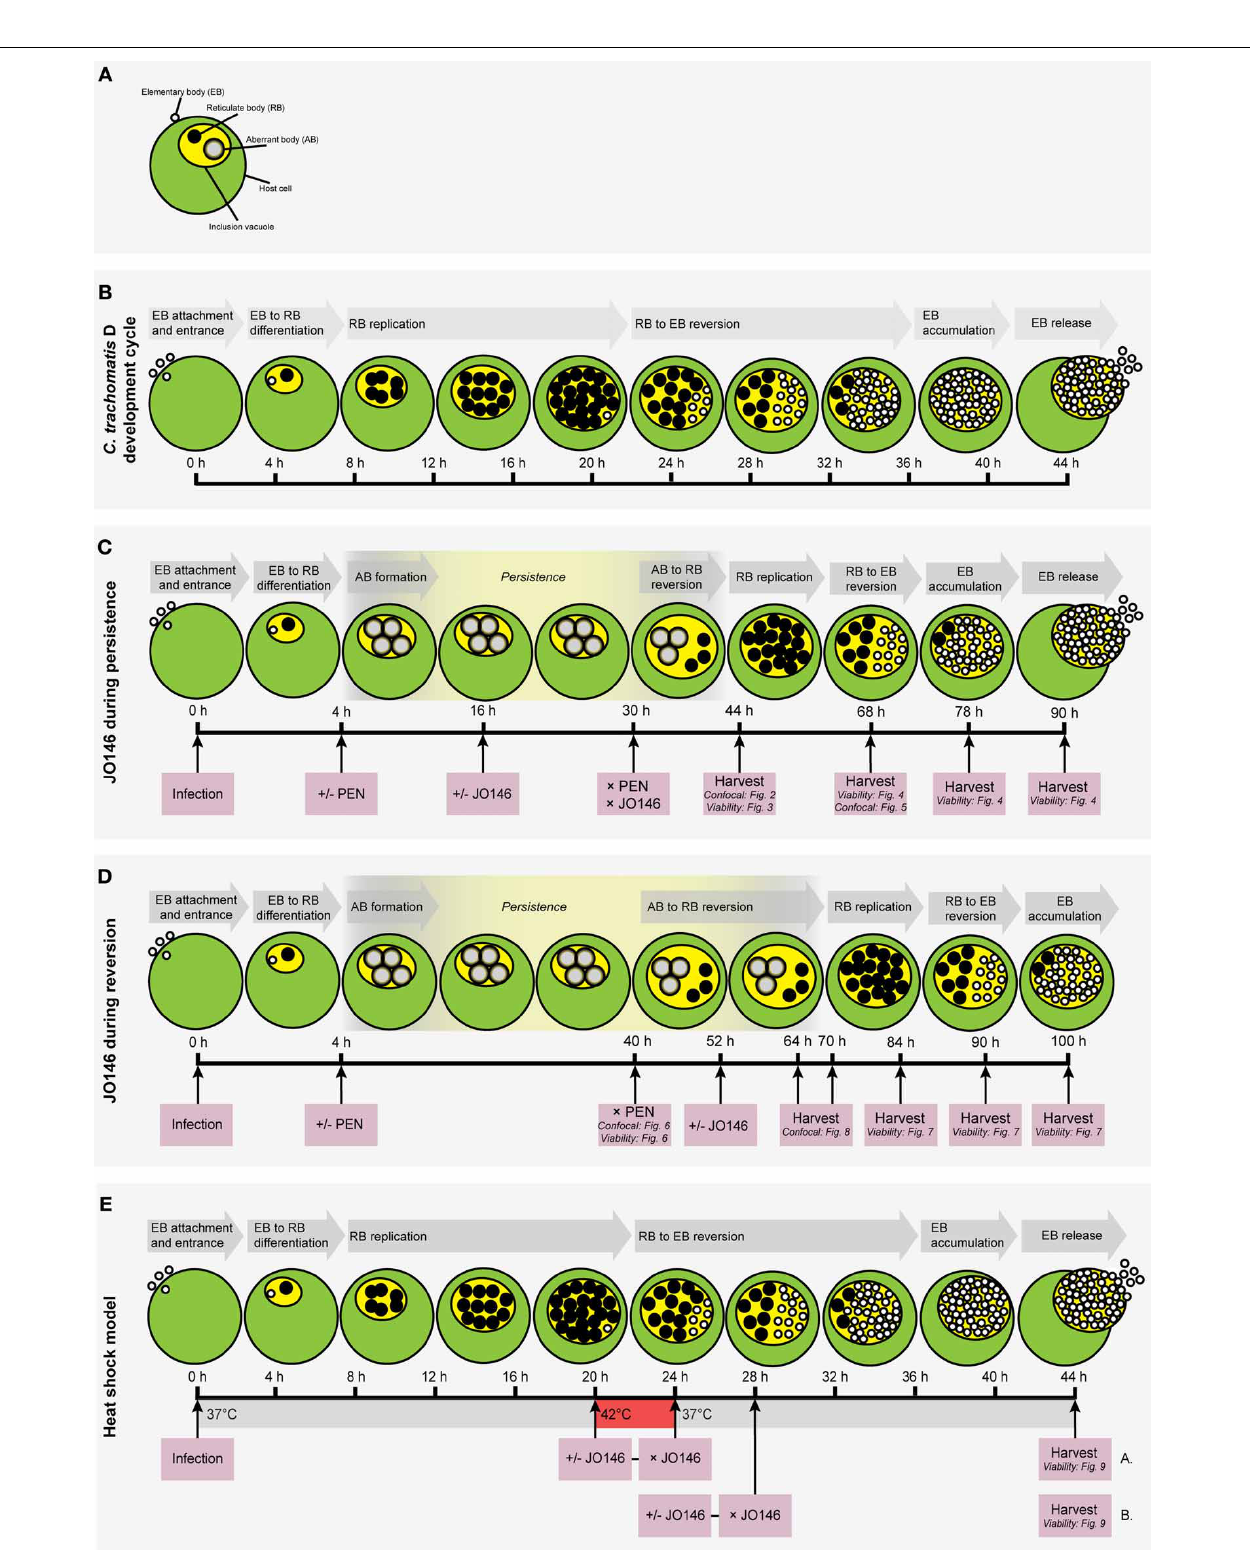
FIGURE 1 | Flow chart diagrams of methodologies used in this manuscript with cartoon representations of the expected growth phases of the Chlamydia . (A) Key to the components of a Chlamydia- infected host cell. Small, open circles: elementary bodies (EB); large black circles: reticulate